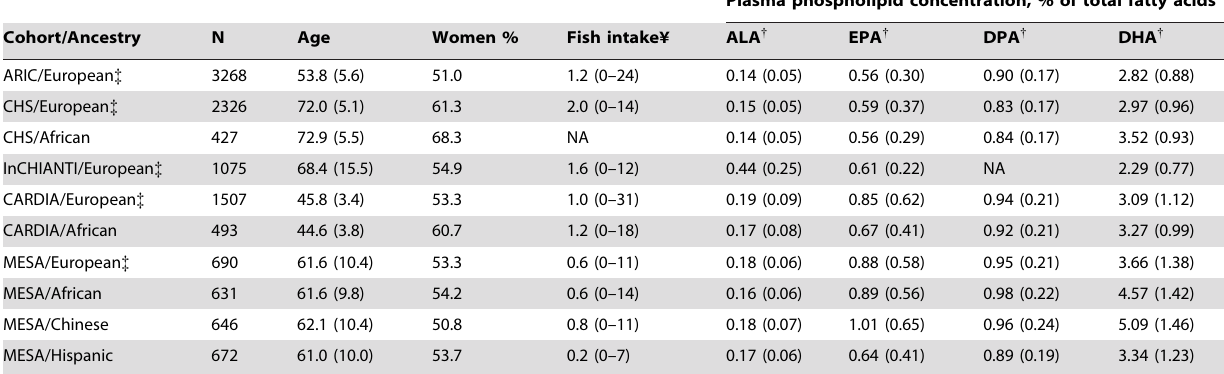
Table 1. CHARGE cohorts